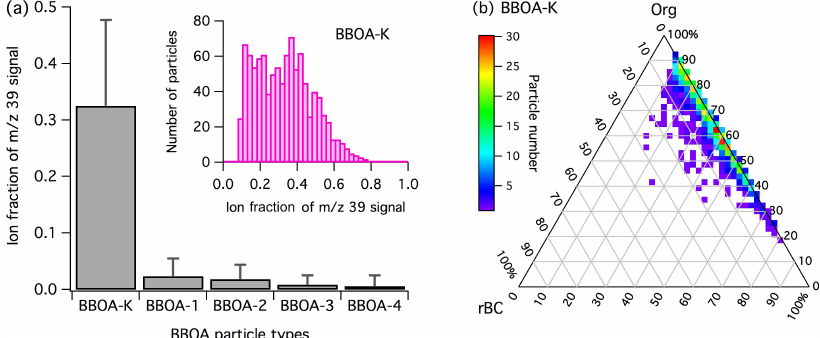
Figure 3. (a) Ion fraction of m/z 39 signal (a tracer of K + ) for each BBOA-related particle class. Histogram of the ion fraction of m/z 39 for the BBOA-K particle class (inset). (b) Ternary plot of rBC, Org BC , and K ion signal for the five BBOA particle